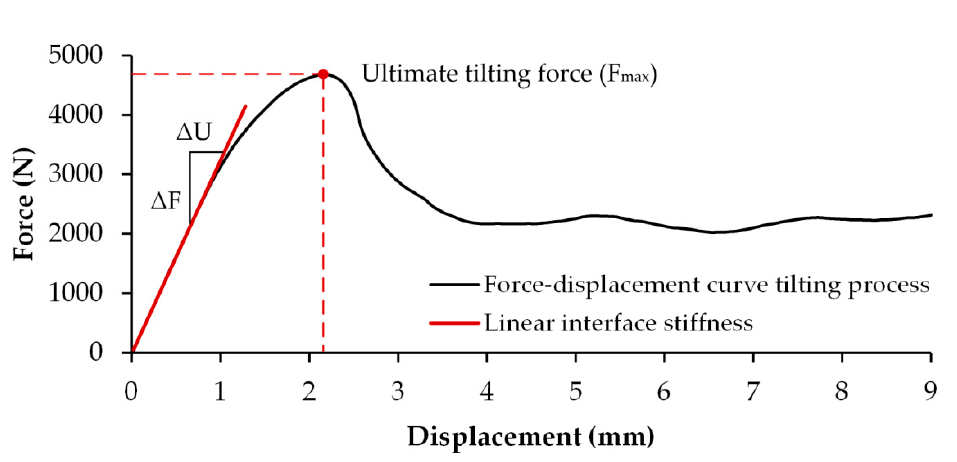
Figure 4. Typical force–displacement curve of the acetabular cup tilt, including the different fixation stability parameters: ultimate tilting force (F max ) and interface stiffness (k inter = Δ F/ Δ U).